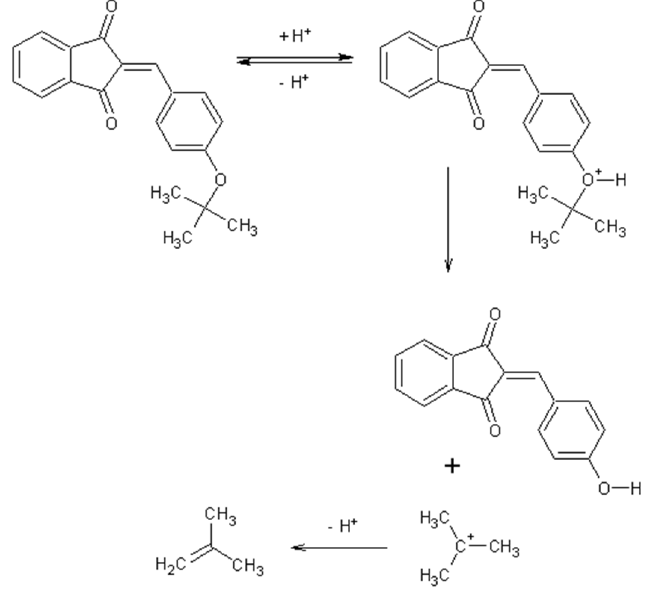
Figure 1. Mechanism of the synthesis reaction of 2-[(4-hydroxyphenyl) methylidene]-1H-indene-1,3 (2H)-dione.